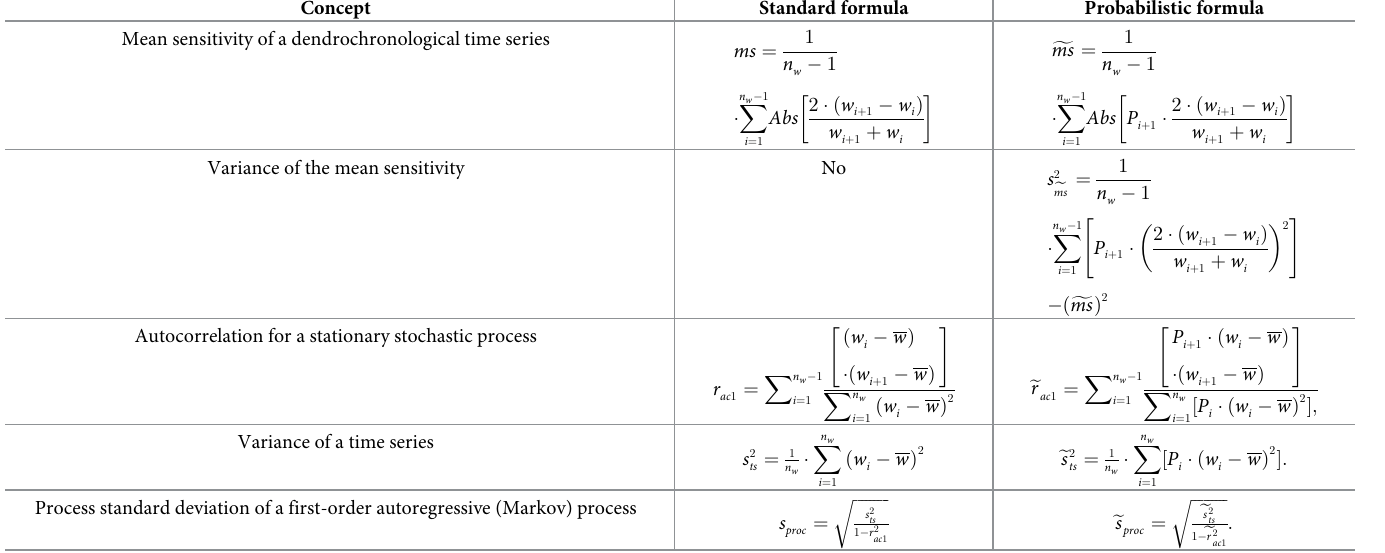
Variance of the mean sensitivity